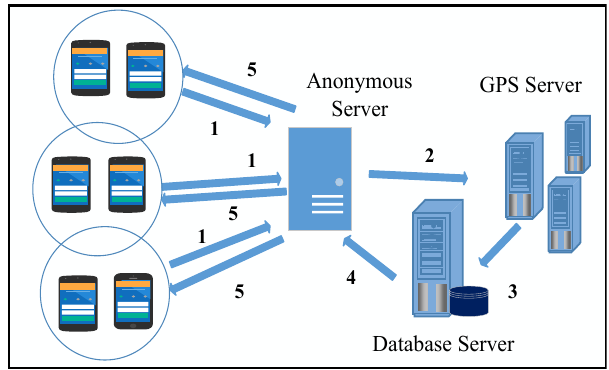
Figure 2. Privacy preserving K-Anonymity architecture integrated with